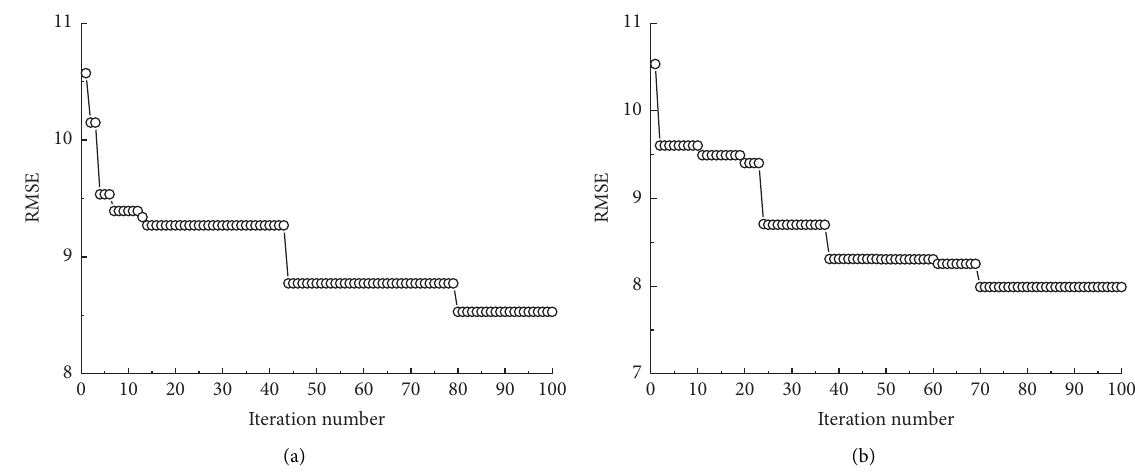
Figure 5: The optimised processes of SVM models using GA and PSO. (a) GA-SVM. (b) PSO-SVM.